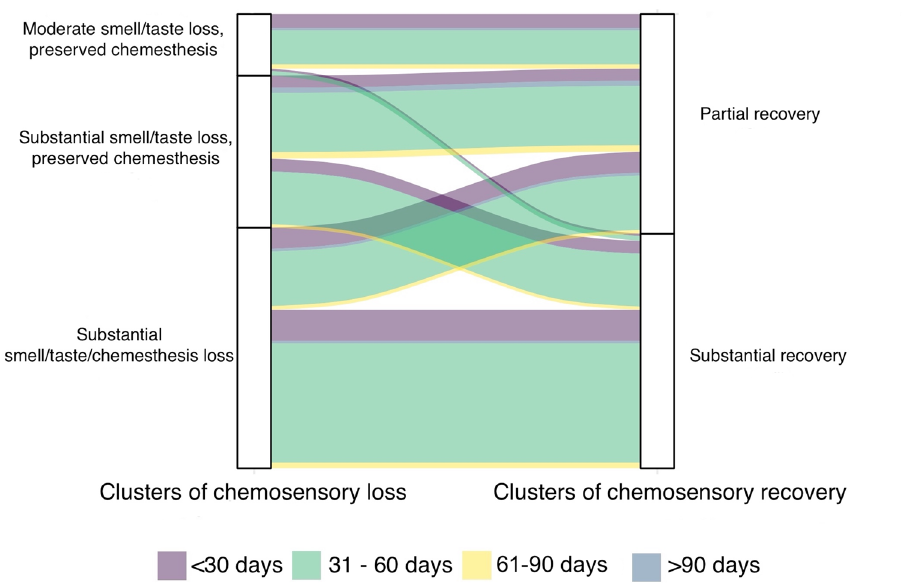
Figure 3. Alluvial plot showing the pattern of chemosensory loss and recovery clusters in relation to days between the date of onset and completion of the questionnaire. On the left 3 clusters of chemosensory loss while on the right 2 clusters of chemosensory recovery. The flows between the blocks depict the path from loss to recovery. The different colors of flows represent the different time intervals (in days) between the date of onset and completion of the questionnaire. The width of the flow represents the fraction of participants experiencing the recovery either partial or